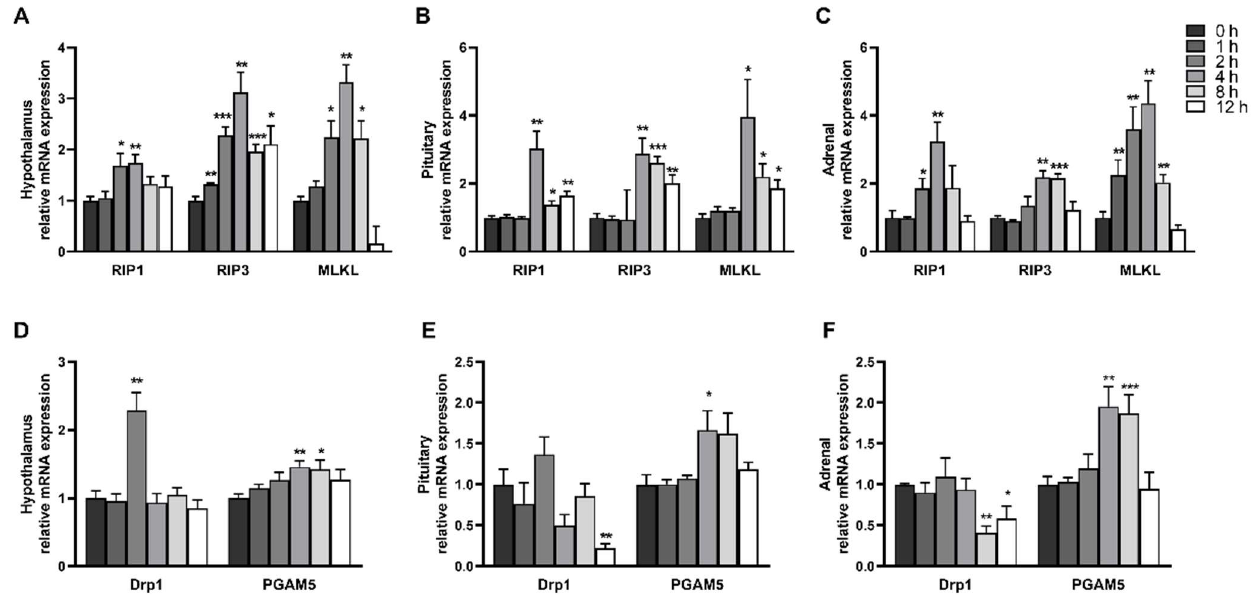
Figure 4. LPS induces dynamic necroptosis of the hypothalamus, pituitary and adrenal gland: ( A ) mRNA expression of RIP1 , RIP3 , and MLKL in the hypothalamus; ( B ) mRNA expression of RIP1 , RIP3 , and MLKL in the pituitary gland; ( C ) mRNA expression of RIP1 , RIP3 , and MLKL in the adrenal gland; ( D ) mRNA expression of DRP1 and PGAM5 in the hypothalamus; ( E ) mRNA expression of DRP1 and PGAM5 in the pituitary gland; and ( F ) mRNA expression of DRP1 and PGAM5 in the adrenal gland. The pigs in LPS groups were injected with LPS at 100 µ g/kg BW, and then were sacrificed at 1, 2, 4, 8, or 12 h after LPS challenge. Values are means ± SEM, n = 6. * p < 0.05, ** p < 0.01, and *** p < 0.001, significantly different from the control group (0 h). RIP1 , receptor interacting protein kinase 1; RIP3 , receptor interacting protein kinase 3; MLKL , mixed lineage kinase domain-like protein; DRP1 , dynamin-related protein 1; PGAM5 , phosphoglycerate mutase family member 5.